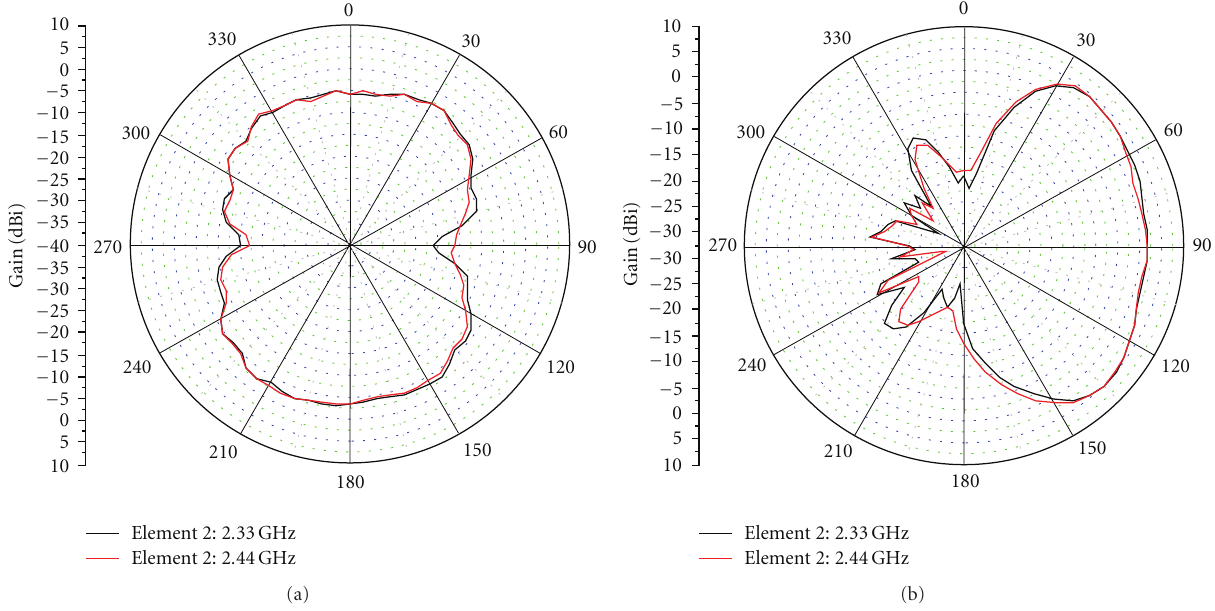
Figure 19: Experimental radiation diagrams of element 2 dipole on reflector plate at 2.33 GHz and 2.44GHz. (a) E-plane (b) xy -plane.